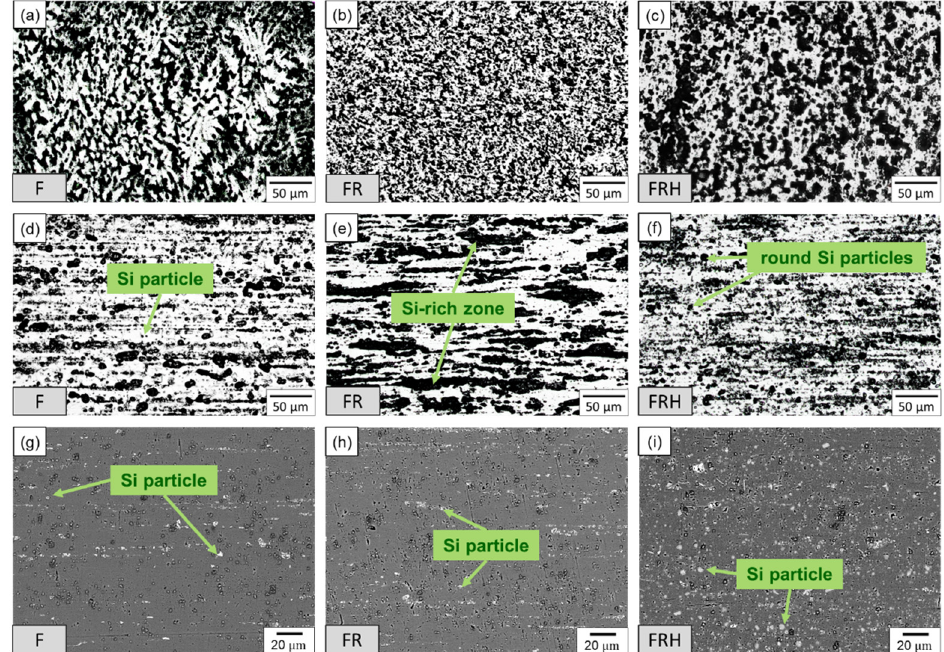
Figure 4. The microstructure evolution of the CCDR Al–Si alloy after cold rolling and T6 heat treatment after cold rolling in the axial section and the transverse section: ( a ) F, transverse, ( b ) F, axial, ( c ) FR, transverse, ( d ) FR, axial, ( e ) FRH, transverse, and ( f ) FRH, axial. BSE image of ( g ) F, axial, ( h ) FR, axial, and ( i ) FRH F, axial.